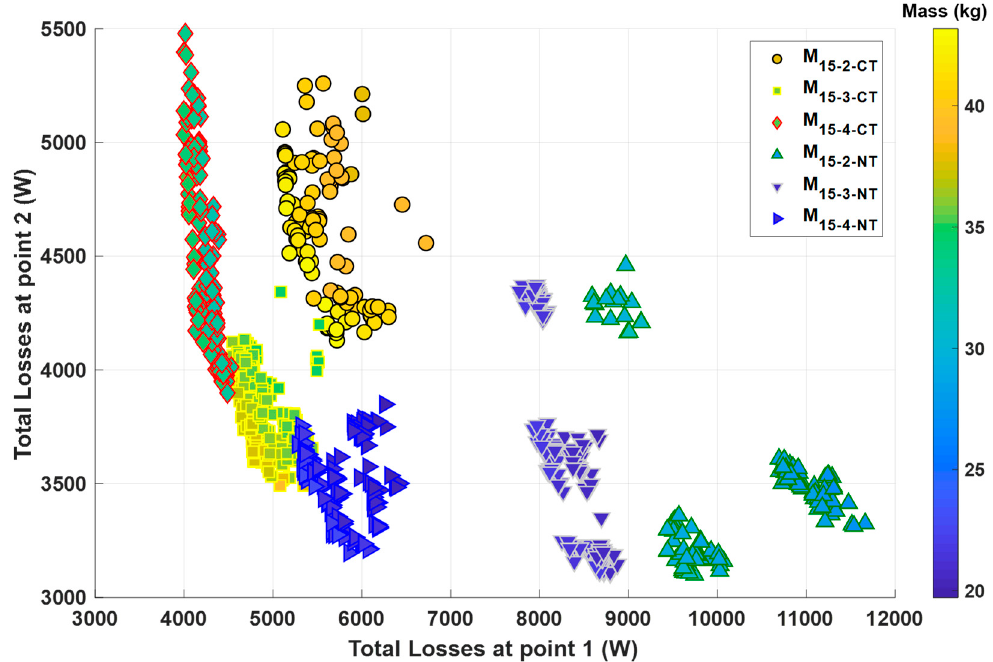
Figure 8. Pareto front of all electric machines operating at Ω (cid:3040)(cid:3028)(cid:3051) = 15,000 rpm .